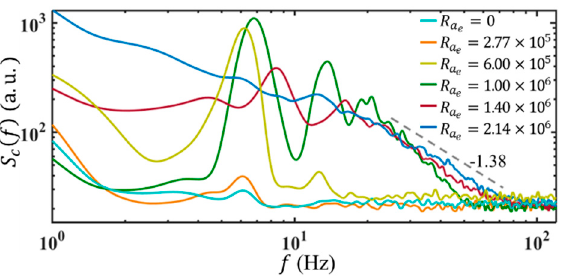
Figure 13. Temporal power spectra of concentration under f f = 130 kHz and different electric Rayleigh numbers. Here Q = 3 µ L/min and the conductivity ratio of the streams is 1:5250. When the electric Rayleigh number is further increased to 𝑅𝑎 (cid:3032) = 1.00 × 10 (cid:2874) , the